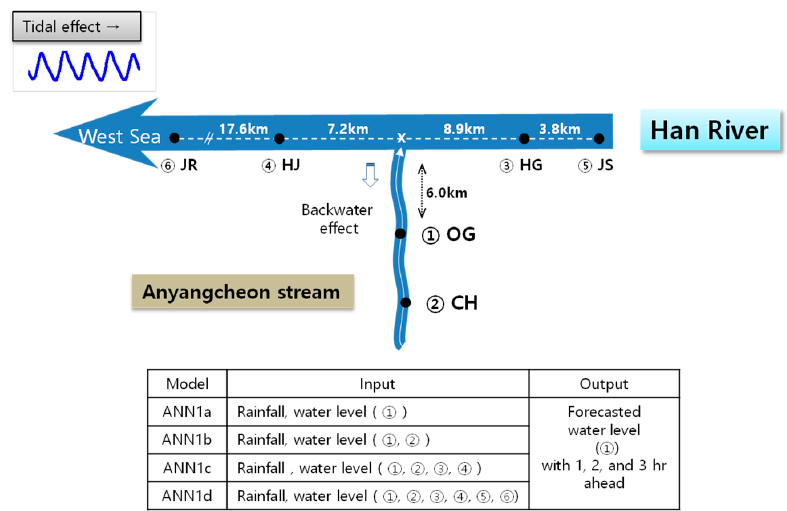
Figure 3. Model construction cases with simple diagram.